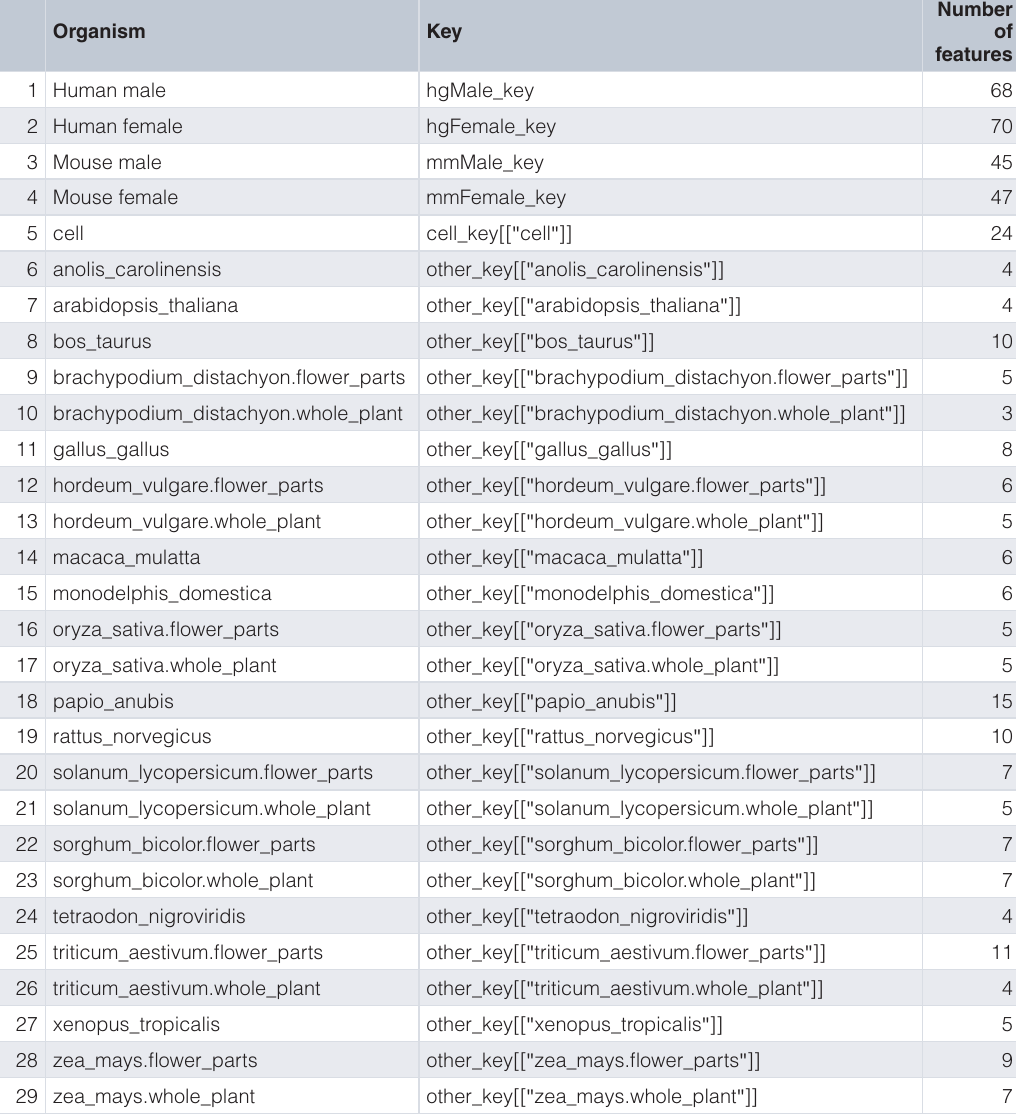
Table 1. Showing all the organisms in gganatogram, how to call their keys, and the number of features per organisms. Organism Key